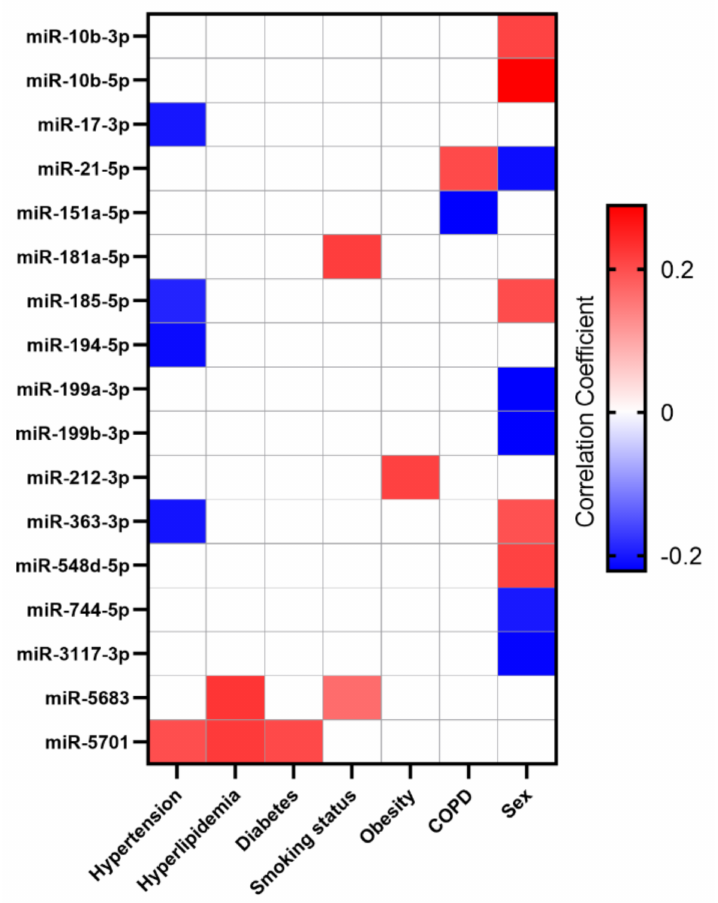
Figure 2. Heat-map of correlation coefficients between significant miRs and risk factors (arterial hypertension, hyperlipidemia, diabetes, smoking status, obesity, chronic lung disease and sex). Positive correlation is highlighted in red, negative correlation in blue. miRs with higher expression levels in female individuals compared to male individuals are illustrated in red and with lower expression in blue. The higher the correlation the brighter the